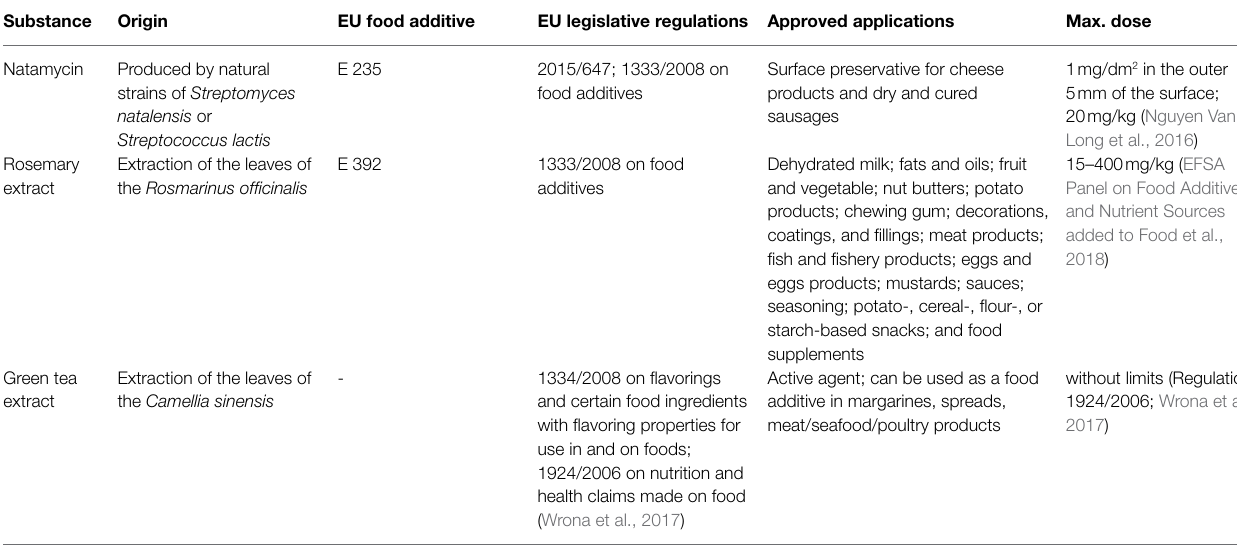
TABLE 1 | Natamycin, rosemary extract, and green tea extract EU legislation conditions.